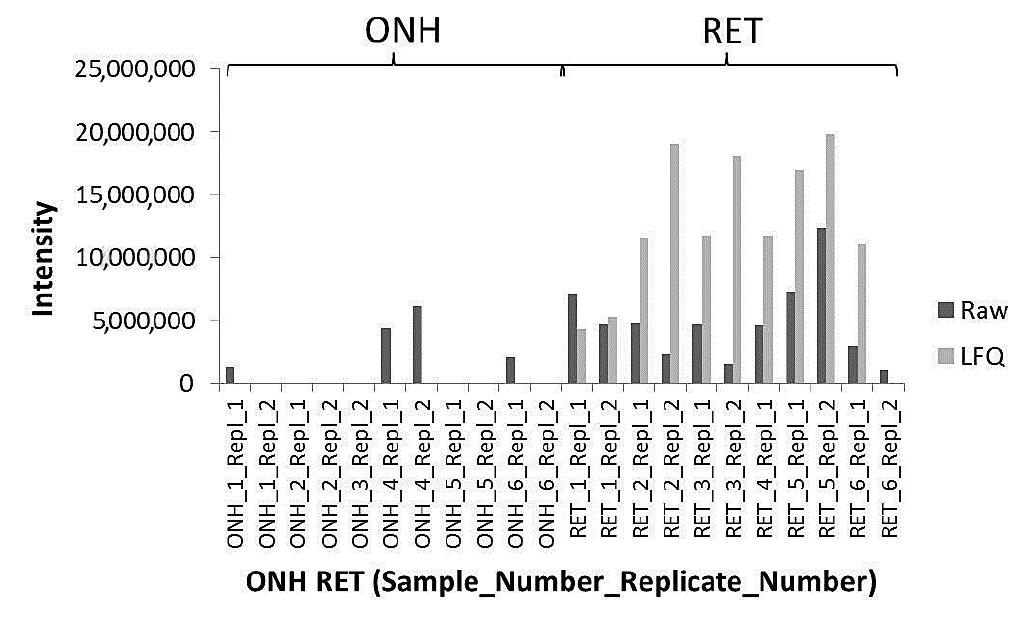
Figure 8. Targeted accurate inclusion mass screening (AIMS) LC–ESI-MS / MS profiling of MECP2 in the remaining ONH and RET tissue pellet samples demonstrating significantly higher MECP2 recovery rates from RET tissue compared to ONH tissue ( p = 0.005898 [Raw], p = 0.000007 [LFQ]; Student’s t